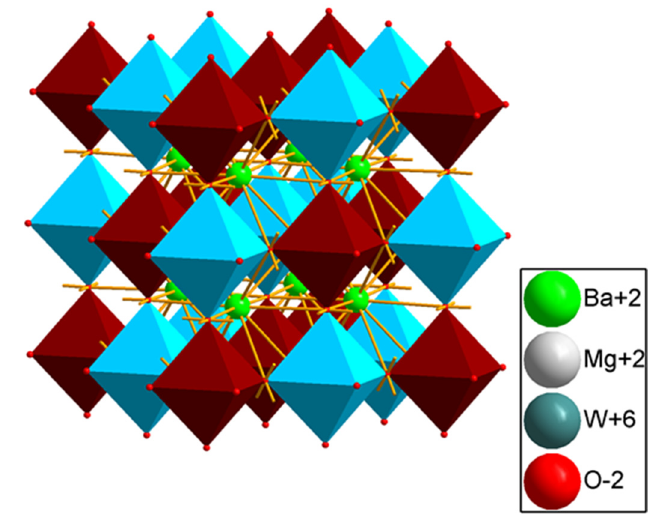
Figure 4. Crystal structure of ordered double perovskite Ba 2 MgWO 6 .